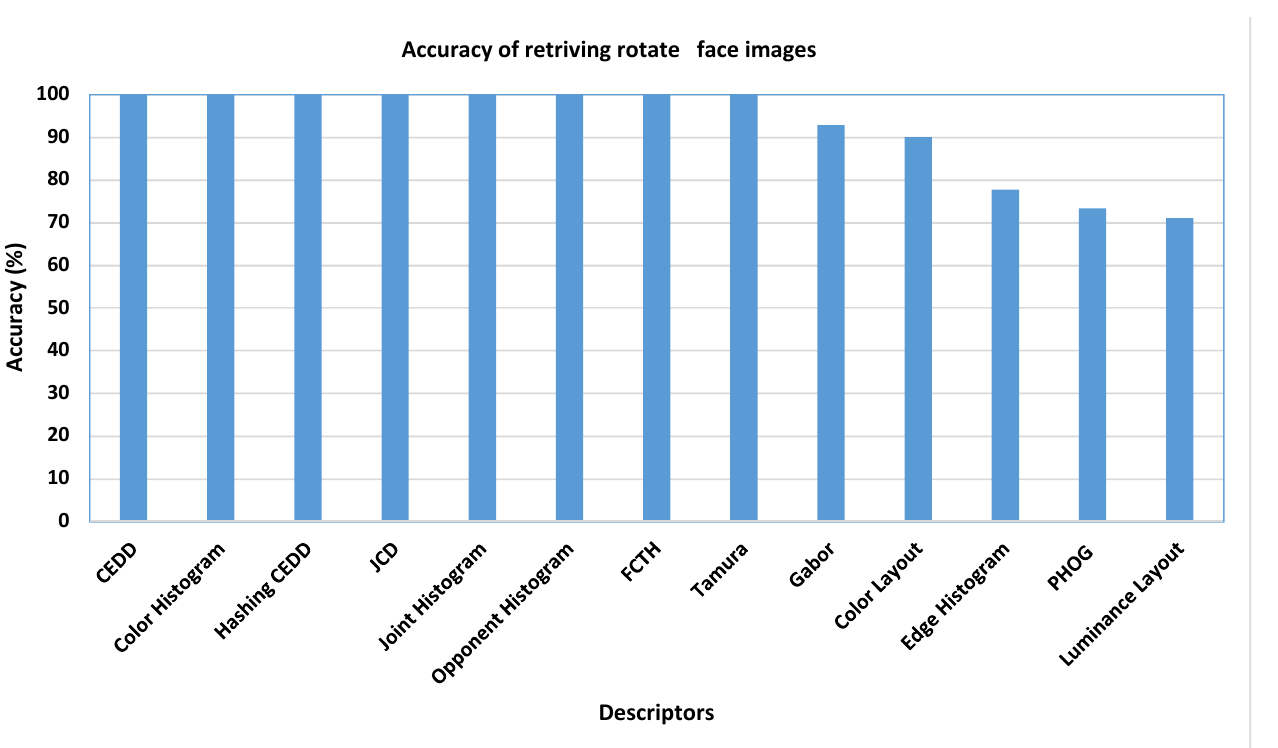
Table 3. Descriptors’ performance for retrieving rotated face images.